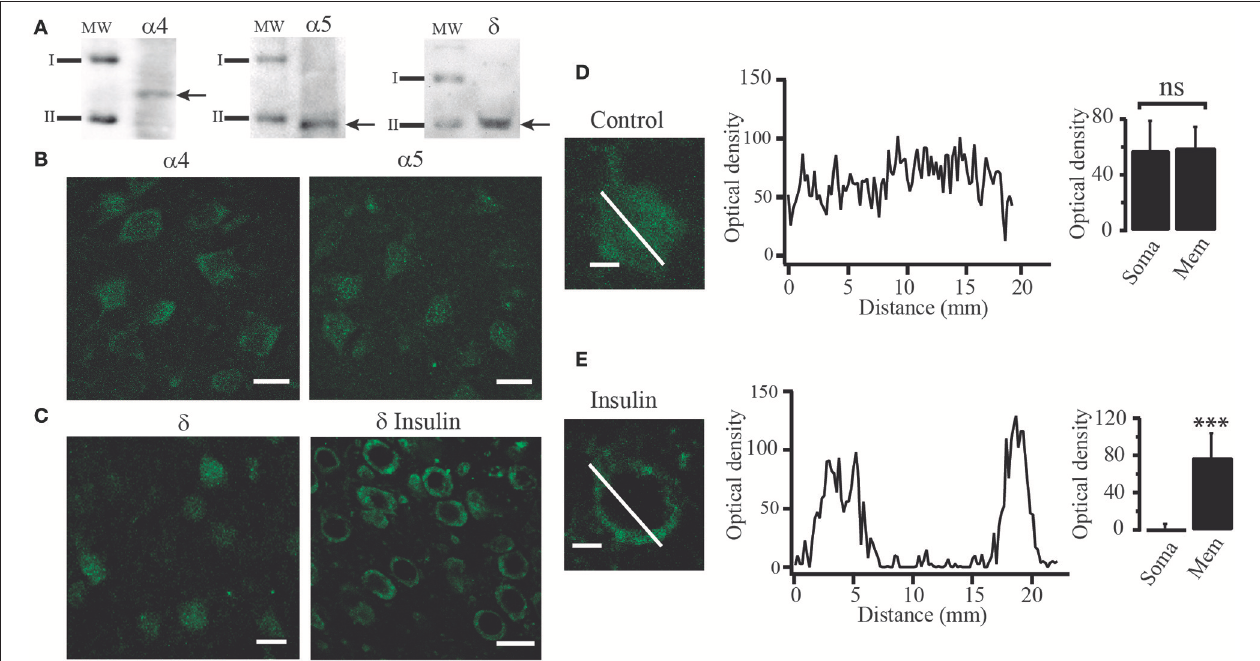
FIGURE 7 | Insulin promotes the translocation of GABA A receptors from the cytoplasm to the cell membrane. (A) Western blot analysis showing immunoreactive products of tissue samples from layer 5–6 of PFC. Arrows indicate bands recognized by the anti- α 4 antibody (left), anti- α 5 antibody (middle), and anti- δ antibody (right), corresponding to protein with masses of 61, 49, and 50 KDa, respectively (I = 75 KDa, II = 50 KDa). (B) Immunoreactivity to α 4 (left) and α 5 (right) GABA A receptor subunits. (C) Immunoreactivity to δ receptor subunit in cells from control slices (left) and cells from slices incubated with insulin ( δ insulin, right). Note that in the cells incubated with insulin, staining was stronger in the boundaries as compared with the control cells (D) High magnification image of a single non-incubated cell (control) stained with an anti- δ antibody (left). The graph in the middle shows the optical density measured through the length of the white line (distance). Optical density had small variations along the cell. Bar graphs indicate no difference of the optical density of the membrane (Mem) with respect to the soma in 24 cells (right). (E) A single insulin-incubated cell stained with an anti- δ antibody (left). The graph in the middle shows the optical density measured through the length of the cell (white line). The graph shows two peaks of optical density representing the white line crossing the limits. Note that when the white line crosses the soma the optic density is almost zero. Bar graphs indicate the difference in the staining of the membrane (Mem) with respect to the soma in 28 cells (right). Scale in (B,C) , 20 µ m. Scale in (D,E) , 5 µ m. *** p <